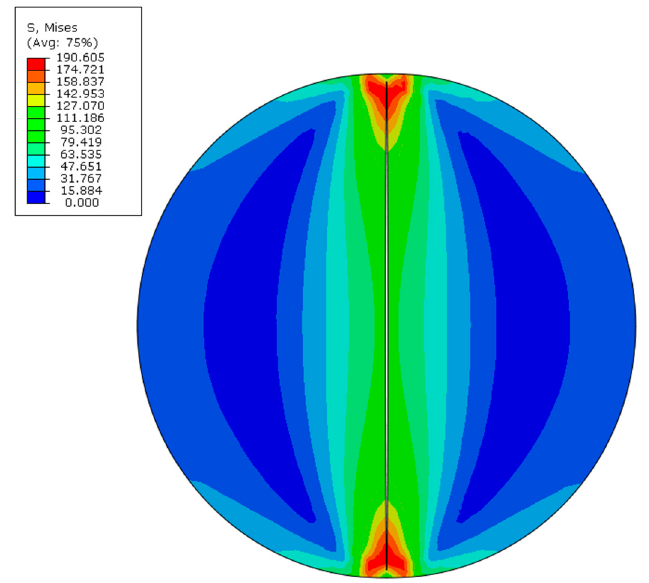
Figure 10. Numerical simulation of Brazilian splitting for ideal homogeneous model.